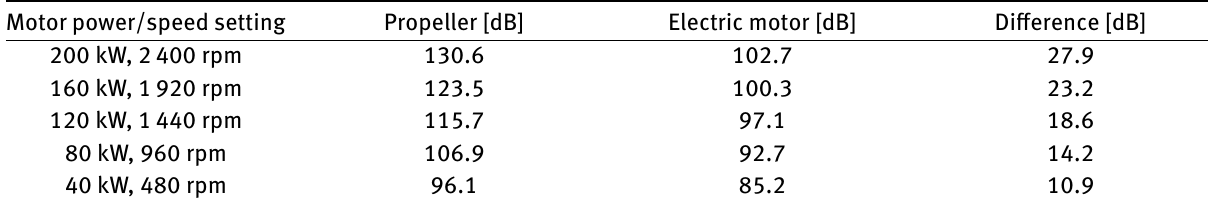
Figure 4: Comparison of SEL data from ANP database and predictions obtained from the source-blending method for a Cessna T206H. (a,b) arrival procedures. (c,d) departure procedures. Table 3: Sound power comparison between propeller and electric motor for a Pipistrel